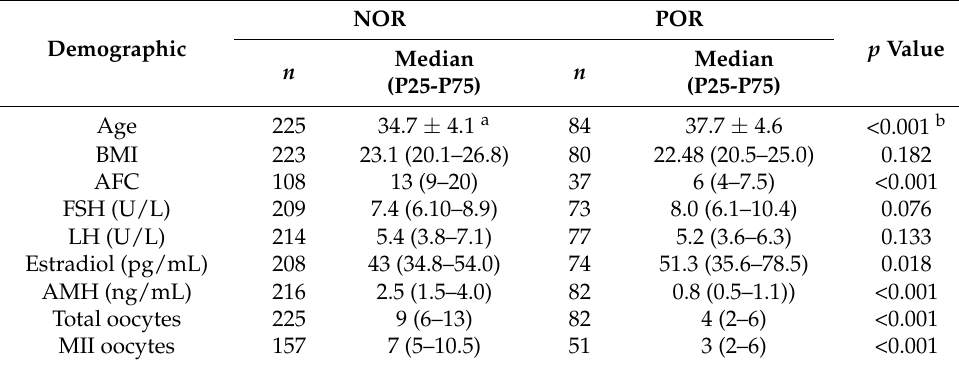
Table 1. Demographics of study cohort.